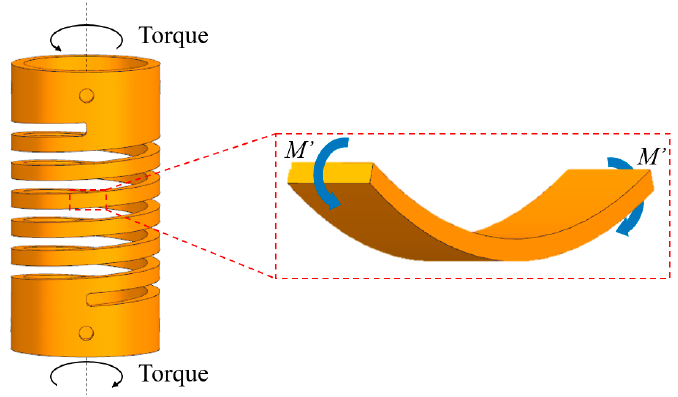
Figure 1. The SMAMS under the torque.